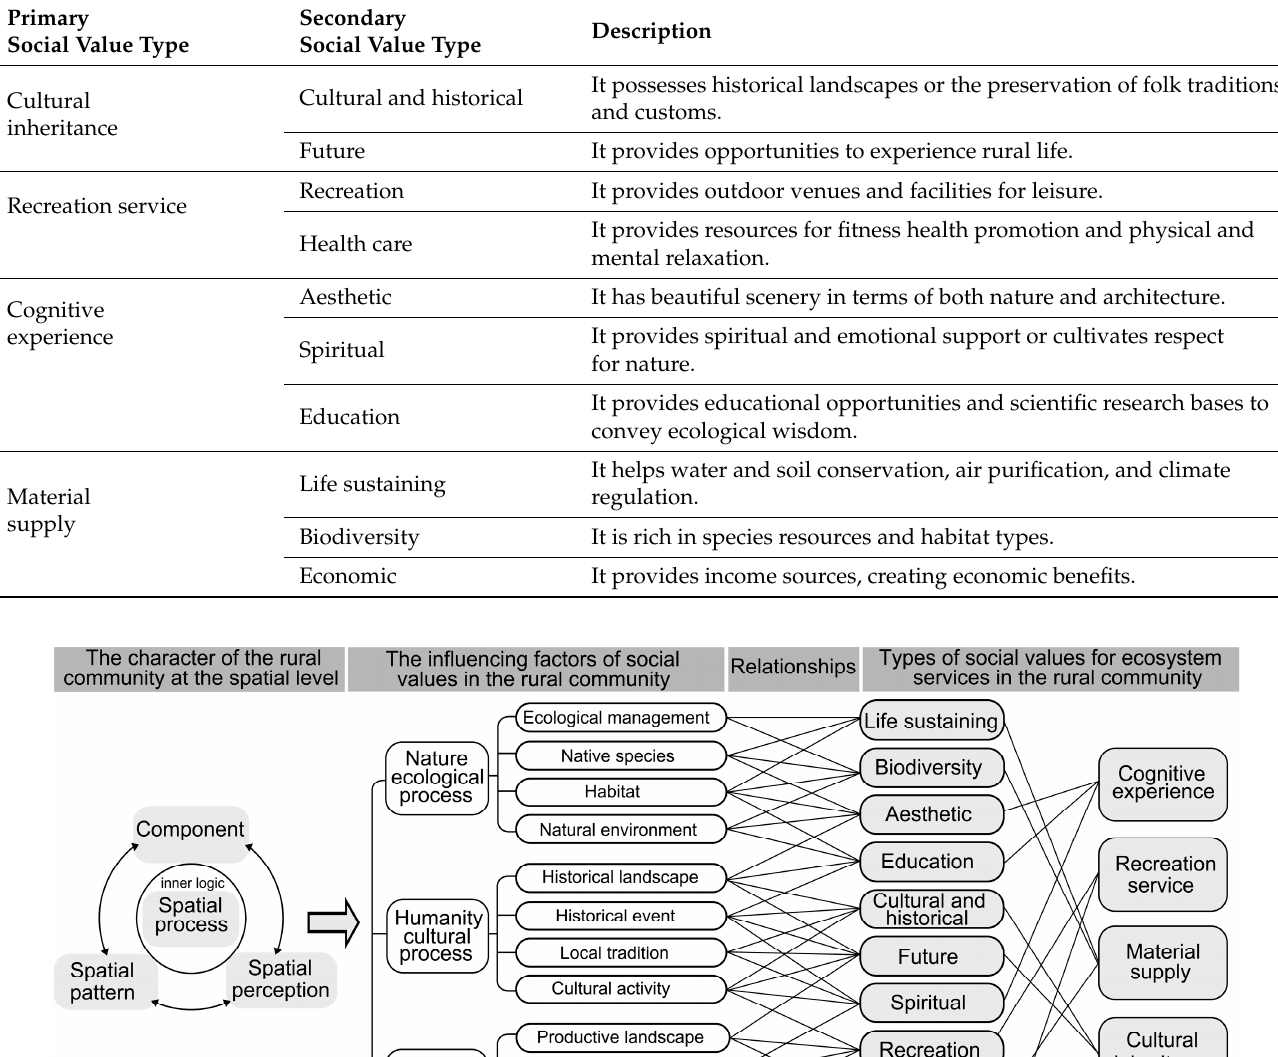
Table 1. Types and descriptions of social values for rural ecosystem services.